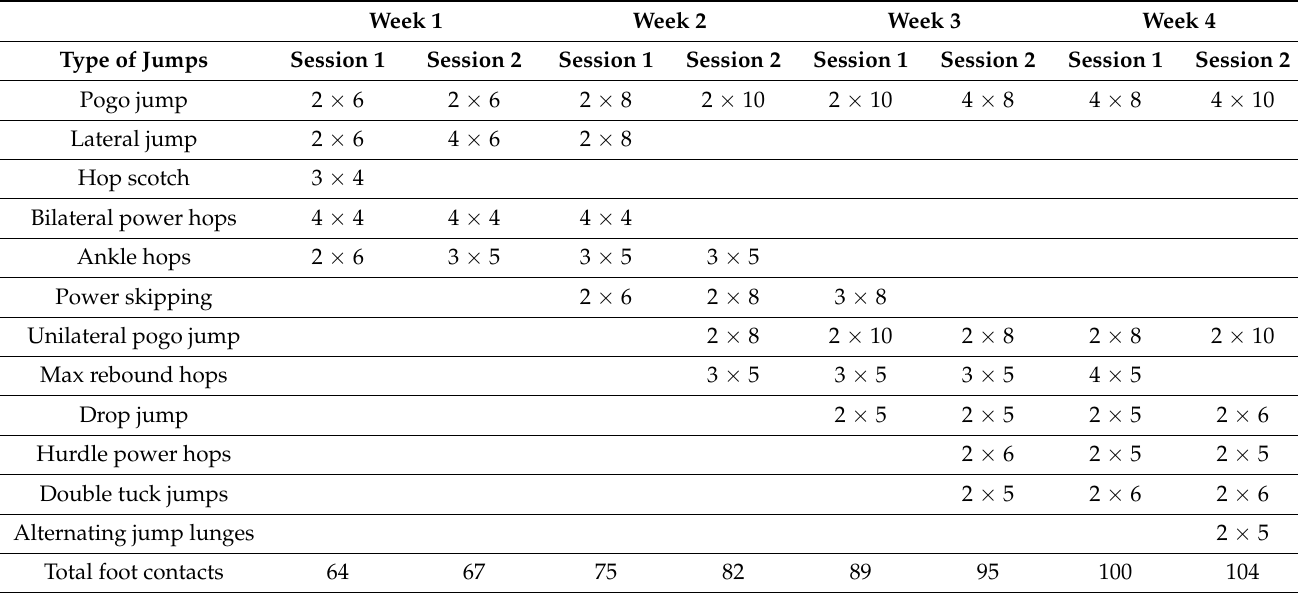
Table 2. Description of the plyometric